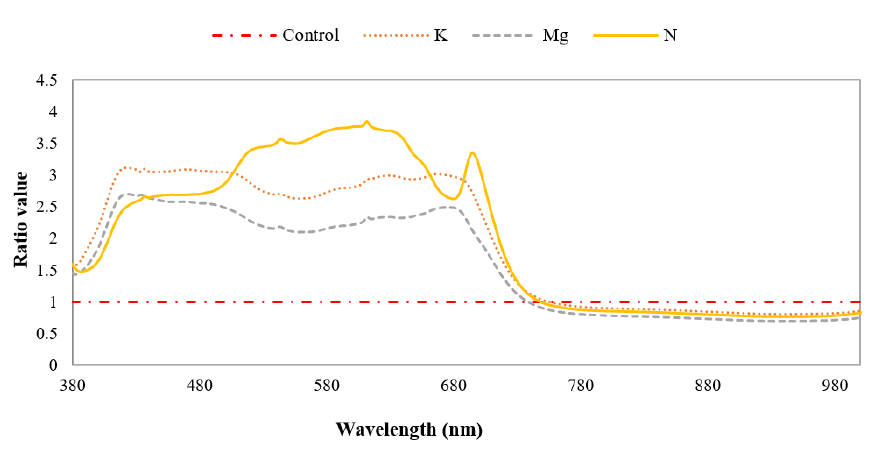
Figure 10. Mean spectral ratios of different nutrient-deficient leaves to control leaf, distinguishing individually different nutrient-deficient leaves.